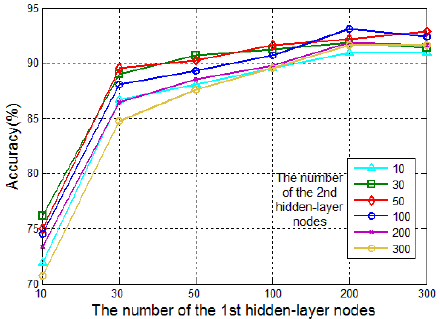
Figure 9. Influence of the number of hidden-layer nodes on classification accuracy.